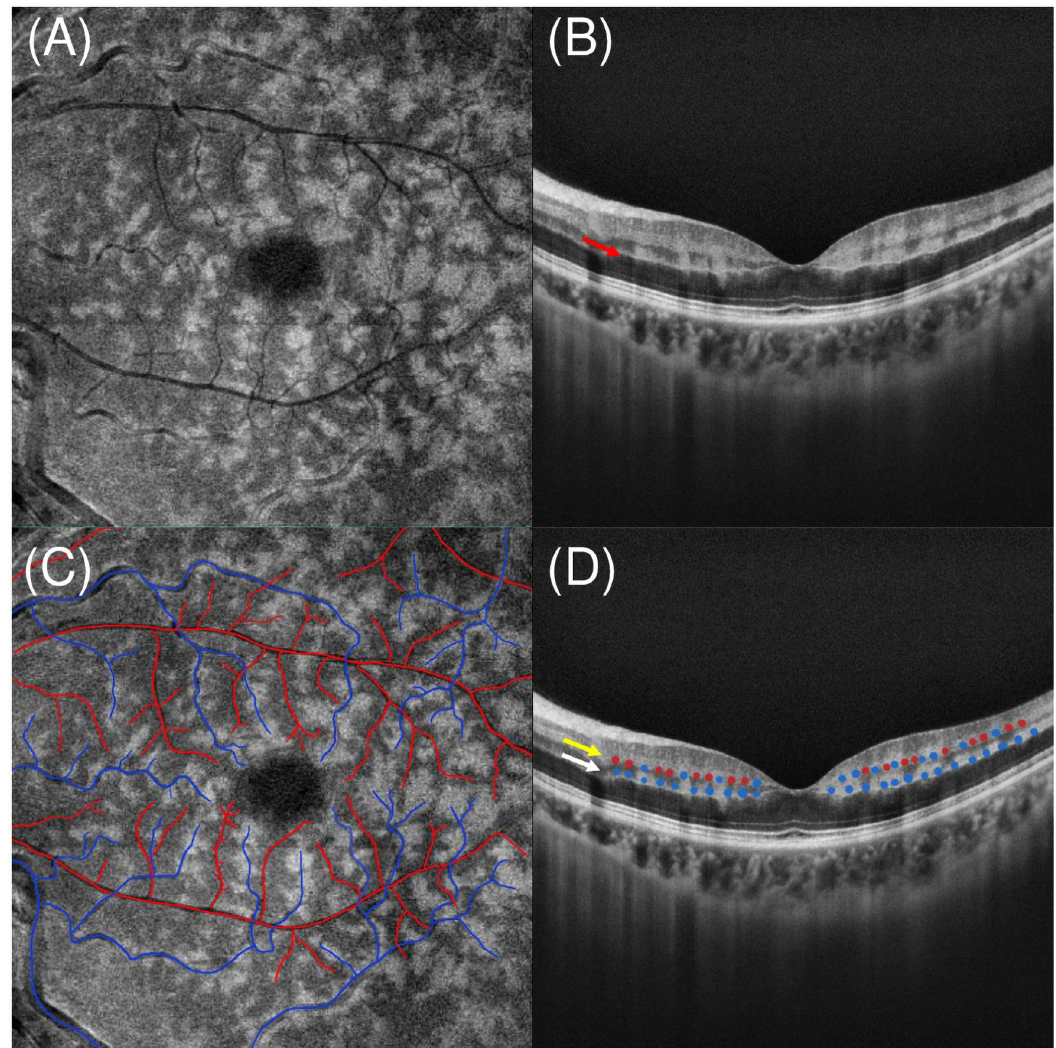
Fig 4. Speculated model of the vascular nature of MCP and DCP. OCT findings from a patient with central retinal vein occlusion combined with central retinal artery occlusion. En-face OCT segmented at the level of the inner nuclear layer and with vascular mapping illustrates a remarkable and precise perivenular distribution of fern-like PAMM with periarterial sparing (A). Cross- sectional OCT B-scan demonstrates skip PAMM lesions and continuous hyperreflective line of the p-MLM sign (red arrow) (B). In panel C (the same image as A), arterioles colored in red and venules colored in blue. Similar to en-face OCT, skip PAMM lesions from OCT may reveal that the nature of the MCP (yellow arrow) is both venous and arterial with alternate arrangement (D; arterial blood supply indicated in red dots and venous blood supply indicated in blue dots). However, the continuous hyperreflective line of the p-MLM sign might suggest that the nature of the DCP (white arrow) is purely venous according to our speculation (D; venous blood supply indicated in blue dots). OCT: optical coherence tomography, PAMM: paracentral acute middle maculopathy, p-MLM: prominent middle limiting membrane, MCP: middle capillary plexus, DCP: deep capillary